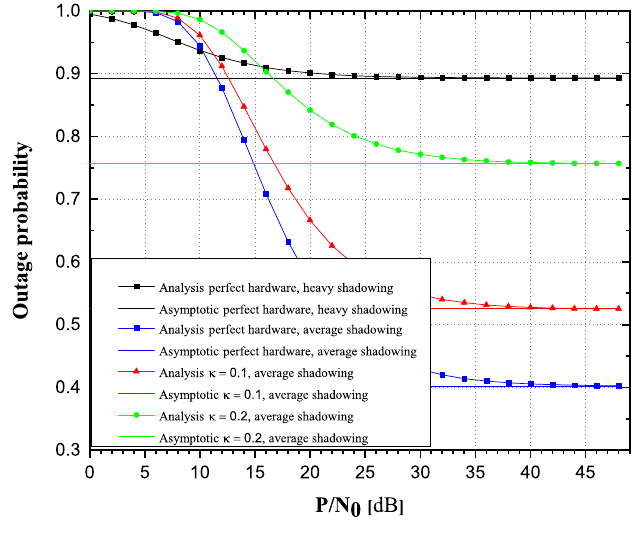
Figure 6. Rician-shadowed fading channels: Outage probability versus P / N 0 .